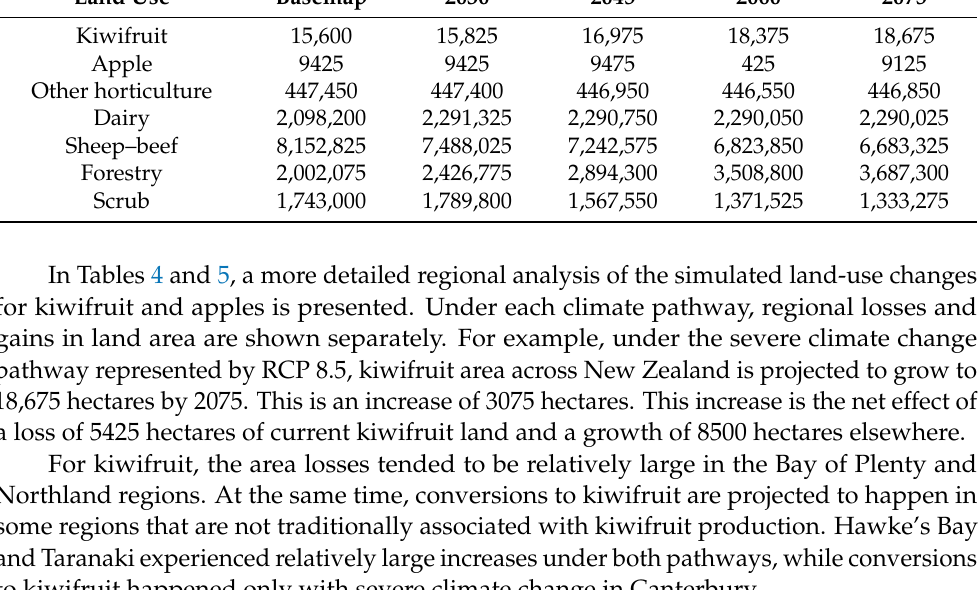
RCP = Representative Concentration Pathway.